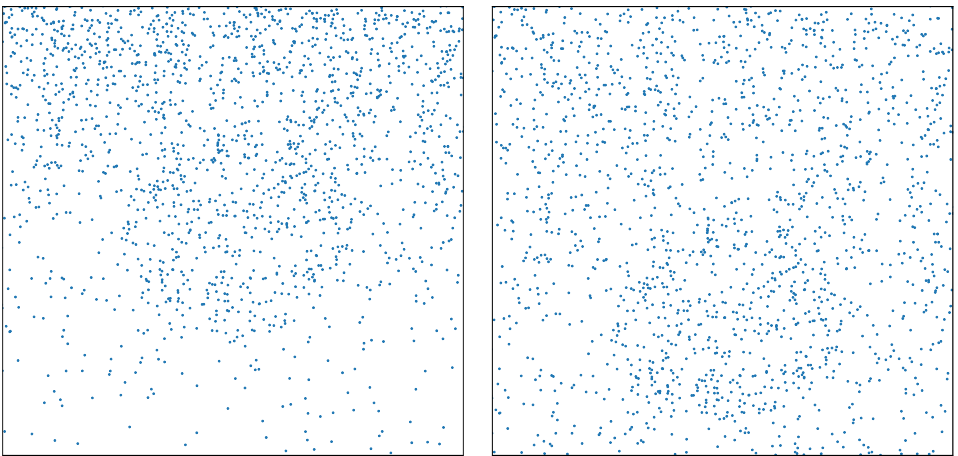
Figure 35 . The same as figure 32, but for the example with exponentially increasing background considered in section A.2. Here we use a weaker signal, with N S = 300 points, while keeping the same number of background points (1500). Note that the y values in the right panel have been rescaled with the “wrong” transformation (A.2) corresponding to a linearly increasing